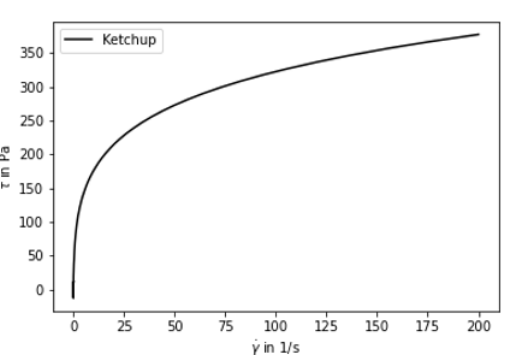
Figure 4: Viscosity measurement of a pectin-containing liquid